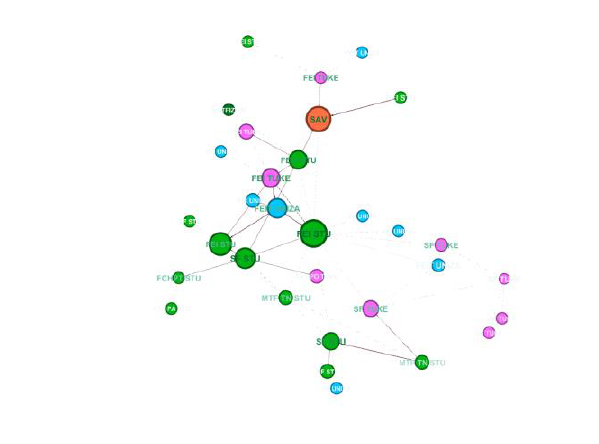
Figure 2. Industry 4.0 network and the position of network actors according to the weighted in-degree and betweenness